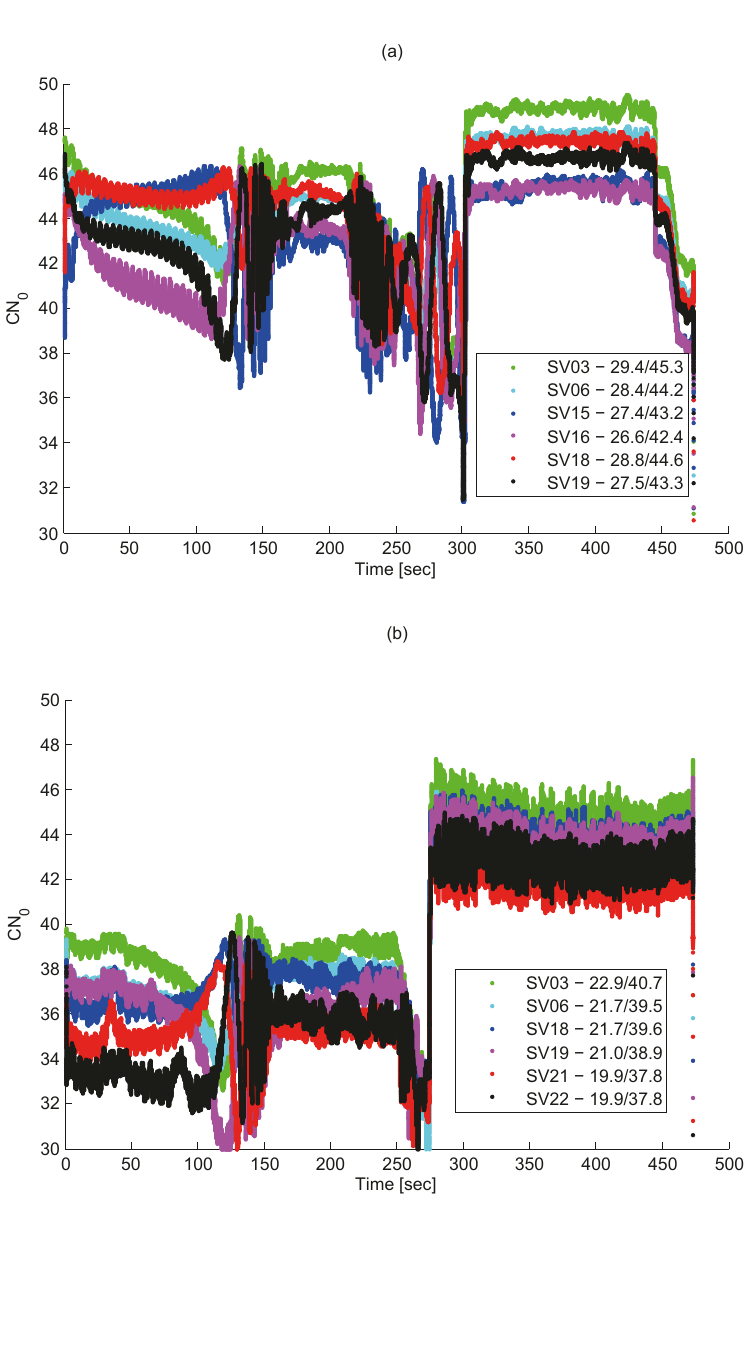
Figure 4: Signal quality, (a) is for FFU C, (b) is for FFU E. In the legends of these two figures, the left numbers are SNR, the right ones are CN 0 , they are smoothed during 1 second